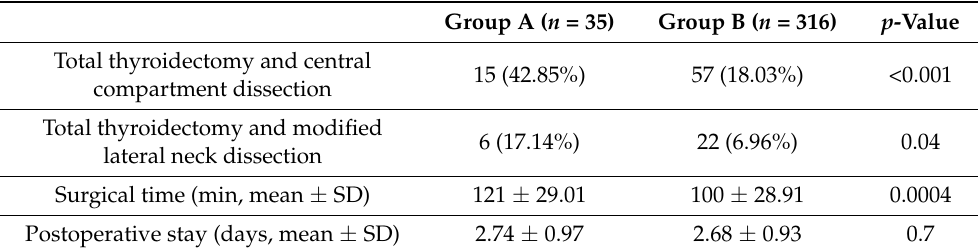
Table 2. Surgical procedure and postoperative